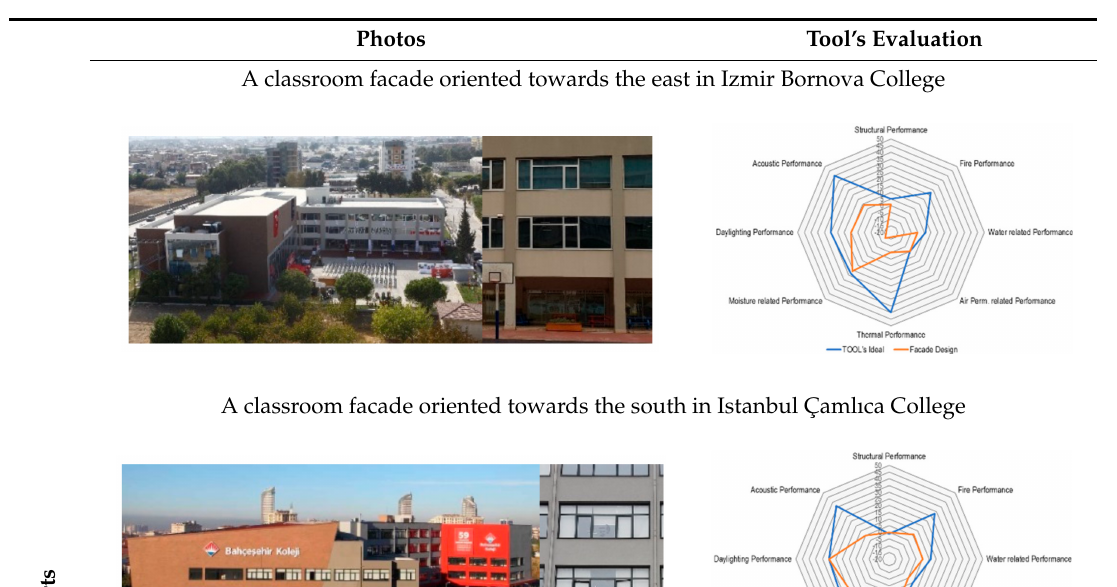
Table 9. Evaluation results of the classroom